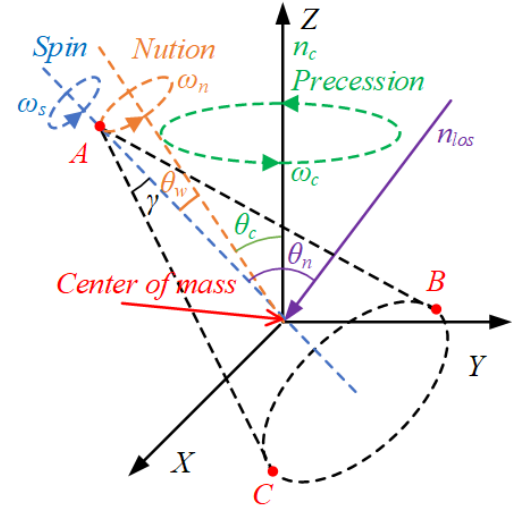
Figure 1. Micro-motion model of cone target with three scattering centers A, B and